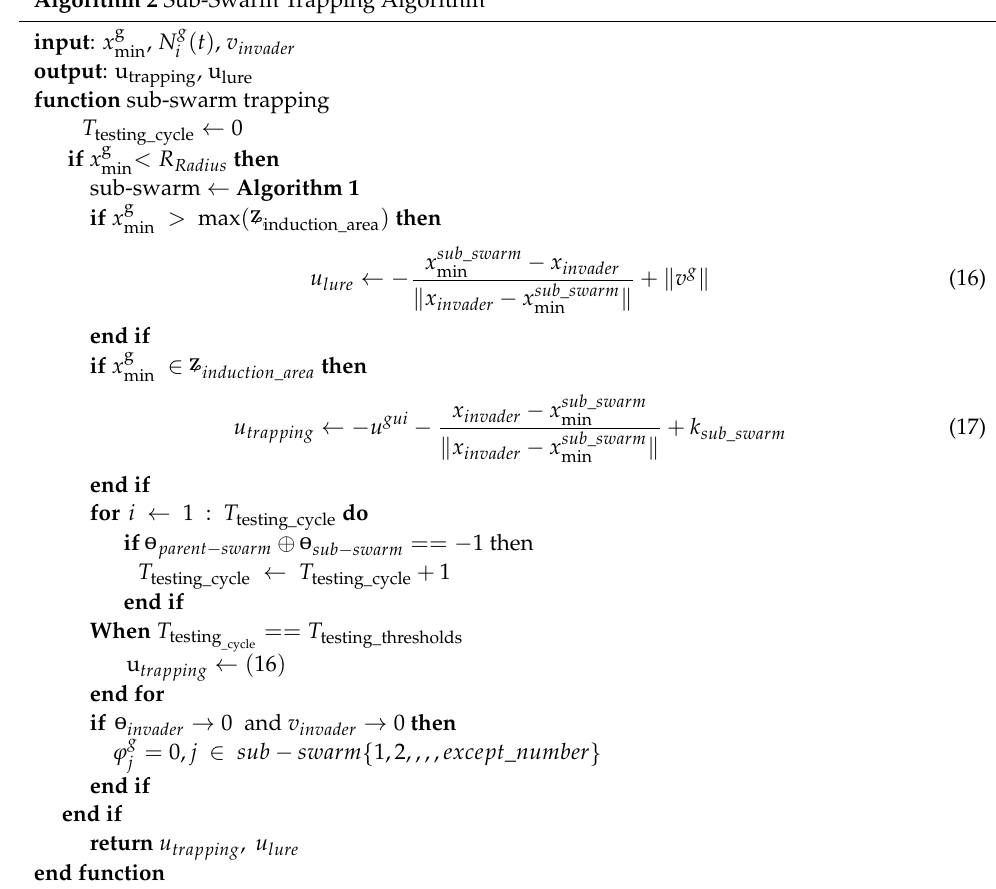
Algorithm 2 Sub-Swarm Trapping Algorithm